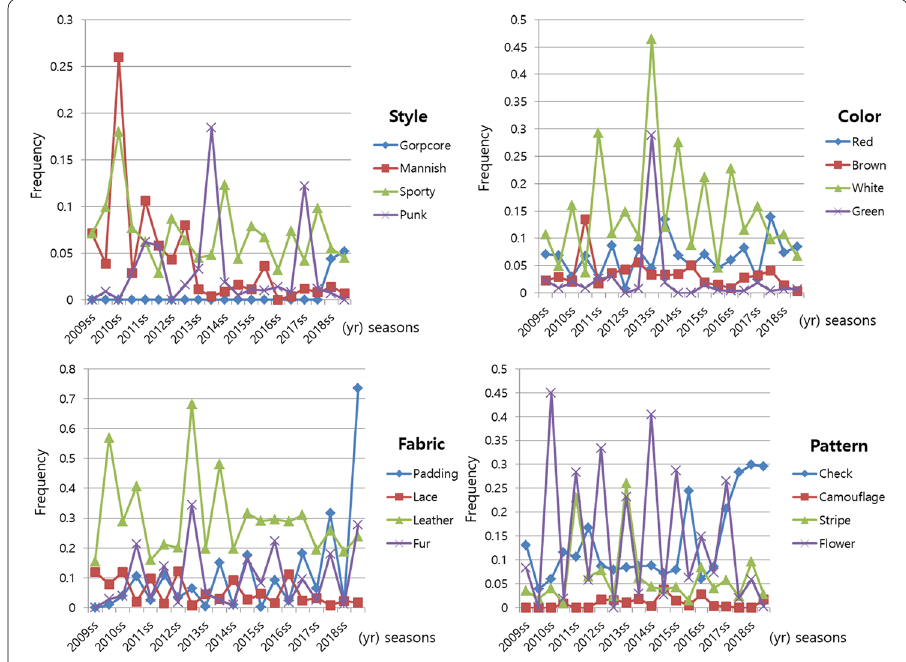
Fig. 2 Time-series cluster results of fashion trend words. Increasing, decreasing, evergreen, and seasonal trends of a style trend words, b color trend words, c fabric trend words, and d pattern trend